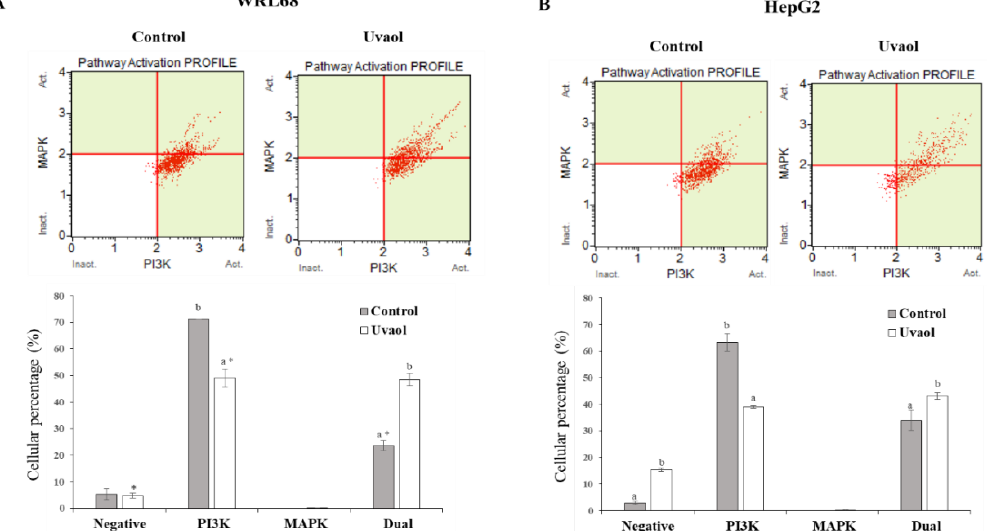
Figure 8. AKT/PI3K and ERK/1/2/MAPK dual pathway determination was performed according to the Muse™ PI3K/MAPK Dual Pathway activation kit. Panel ( A ) correspond to WRL68 cells and panel ( B ) to HepG2 cells. Treatments included cells not treated and cells incubated with IC 50 of uvaol for 24 h. Top: dot plots show a representative experiment of the different treatments. Bottom: percentage of non-activated cells and cells with PI3K, MAPK and Dual pathway activated for each treatment. Values are expressed as mean ± SEM (n = 12). Different letters indicate significant differences between treatments for each activated pathway and an asterisk indicates significant differences between cell lines for each treatment and activated pathway ( p < 0.05).